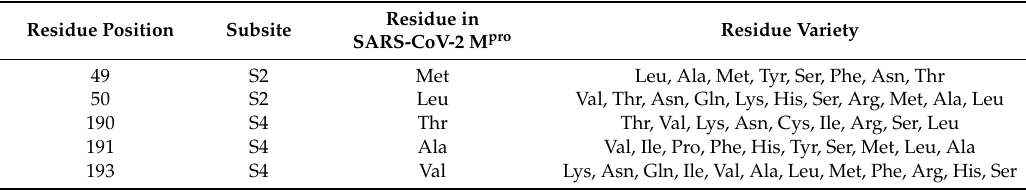
Figure 3. Analysis of binding subsites of SARS-CoV-2 active site using PDB 6LU7: The larger image is the overall active site. The S2 subsite is shown in the smaller image in each panel. This orientation shows the characteristics of inside of the S2 subsite that cannot be seen in the larger image. ( A ) Subsites S1, S1 ′ , S2, and S4. N3 inhibitor is shown for orientation; ( B ) Conservation of subsites. Pink and magenta represent regions that are more conserved, dark cyan and light cyan represent regions that are less conserved. White represents regions without a high or low degree of conservation. ( C ) Electrostatic potential map of subsites. Red represents areas of negative charge density, while blue represents regions of positive charge density. White represents neutral regions. The darker the red or the blue, the greater the degree of negative or positive charge density. ( D ) Hydrophobicity plot of each subsite. The sienna-colored areas represent regions of hydrophobic character. The blue regions represent areas of hydrophilic character. The darker shades of sienna or blue represent greater hydrophobic or hydrophilic character. Table 1. Residue Variation in the Active site of